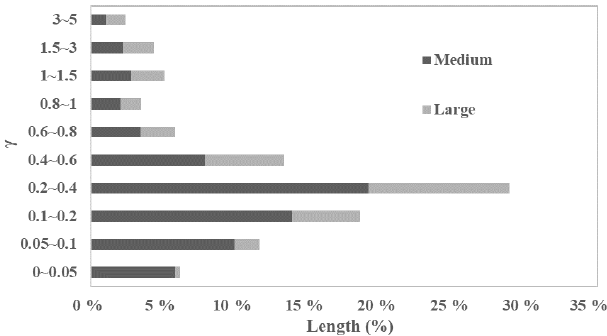
Figure 9. The length percentages of medium and large rivers for different γ value ranges across Australia.